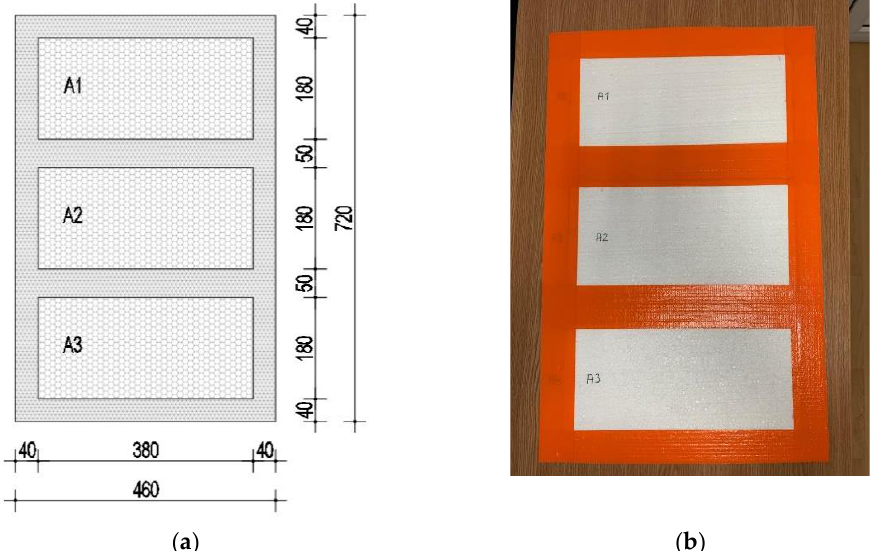
Figure 2. ( a ) Drawing of the panel; ( b ) final panel for testing. (Unit: mm).